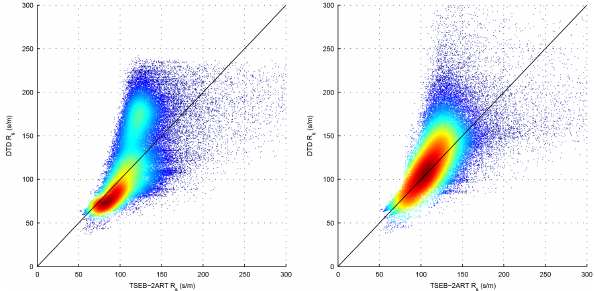
Figure 15. Density scatter plot of over 95000 points comparing re- sistance of heat transfer from the soil surface ( R S ) modelled by the TSEB-2ART and DTD. In the left panel the original DTD formu- lation is used (Norman et al., 2000) and in the right panel the new formulation is used (Eq. 4). Red colour indicates higher density of points, blue colour lower